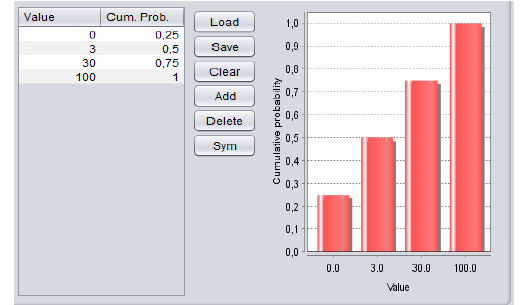
Fig. 12. MS mobile station’s mobility.